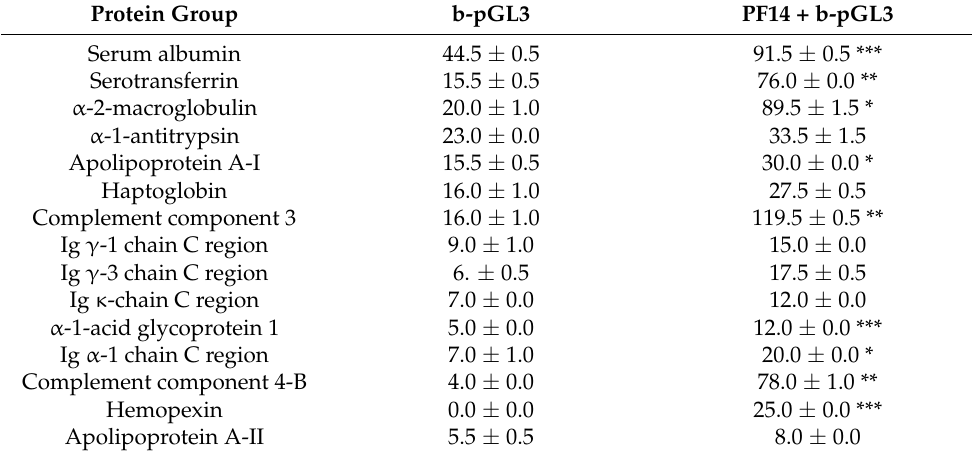
Table 4. Mass-spectrometry analysis of proteins bound to CPP-pDNA nanoparticles from human serum at higher level. Fifteen most abundant proteins in protein corona are listed. Data represents two independent experiments and three technical replicates of each with ± SEM, compared to